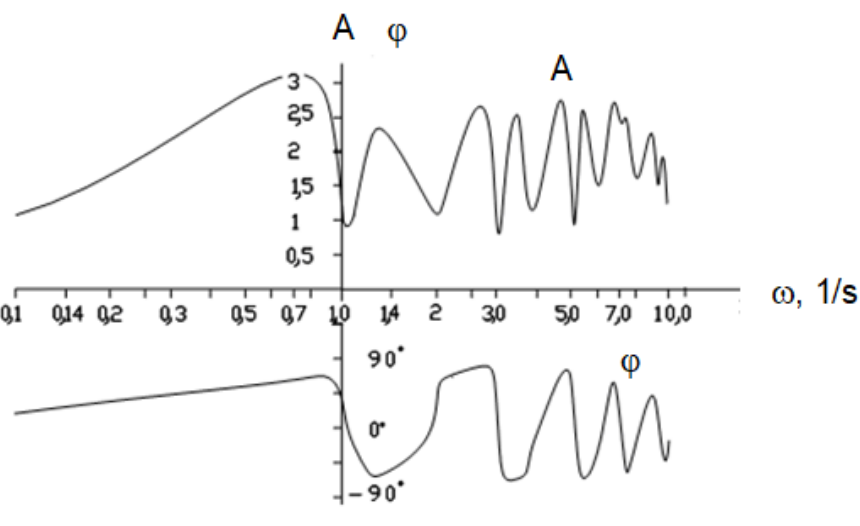
Fig. 2. Amplitude (A) and phase (  ) frequency characteristics of a volumetric hydraulic